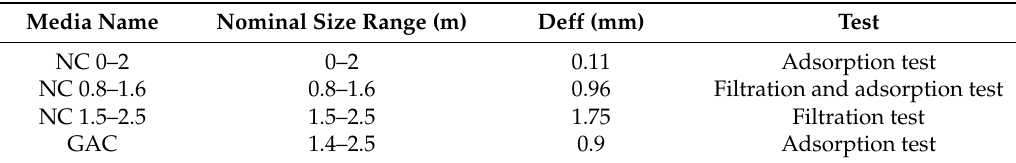
Table 1. Filter media used in the study with corresponding